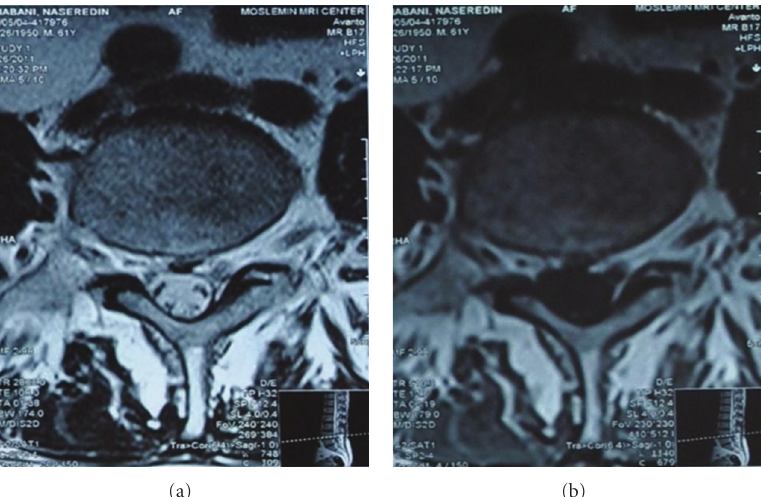
Figure 2: Axial T1- (a) and T2-weighted (b) lumbar MR images showed central protrusion of L4-L5 disc with slight nerve roots compression